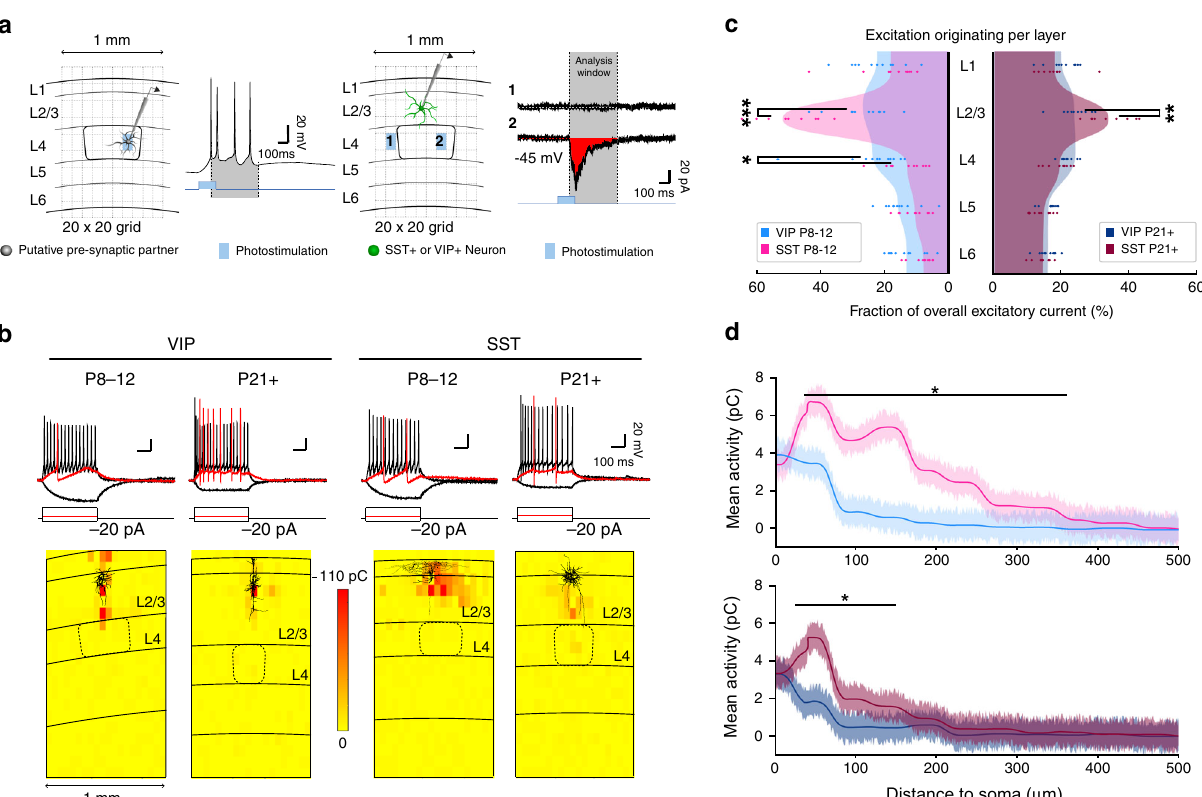
Fig. 3 Distinct functional connectivity motifs onto super fi cial VIP + and SST + cortical interneurons. a Left: a graphic representation of photostimulation celibration with a patched putative pre-synaptic neuron within a neocortical slice indicated with layer boundaries (L1-6). Illumination calibration were done so that the paradigm successfully evoked a short train of APs in the putative pre-synaptic partners. AP discharge is displayed to the right, with the peak of the fi rst AP until after the last AP creating a time-window used for future analysis of evoked currents. Right: schematic representation of photostimulation- based mapping of incoming currents onto interneurons through whole-cell patch-clamp recordings. Overlaid is a schematic of the 20 × 20 grid, indicating the quadrants that can be photostimulated. Two of the AP discharges of the interneuron is shown to the right, with one not eliciting (1) and one eliciting (2) a post-synaptic response. The time-window acquired during calibration is used to register and analyse the currents. b Top: example traces of voltage responses to square hyperpolarizing and depolarizing currents pulses, Δ + 20 pA. Bottom: Heatplot representations of normalized evoked excitatory current integral (in pC), recorded over development (P8 – 12 and P21 + ) from VIP + (left) and SST + (right) IN while perfoming glutamate uncaging in a grid pattern (VIP P8 – 12: 11 cells, VIP P21 + and SST P8 – 12: 10 cells, SST P21 + : 9 cells). c plots of excitatory input onto VIP + and SST + cells (individual dots) averaged per lamina and normalized to average overall excitation within the fi eld of view. The grand average of all cells per group is depicted as a continuous fi lled wave and compared within age groups. One data point has been excluded for display purposes only. Same number of cells as